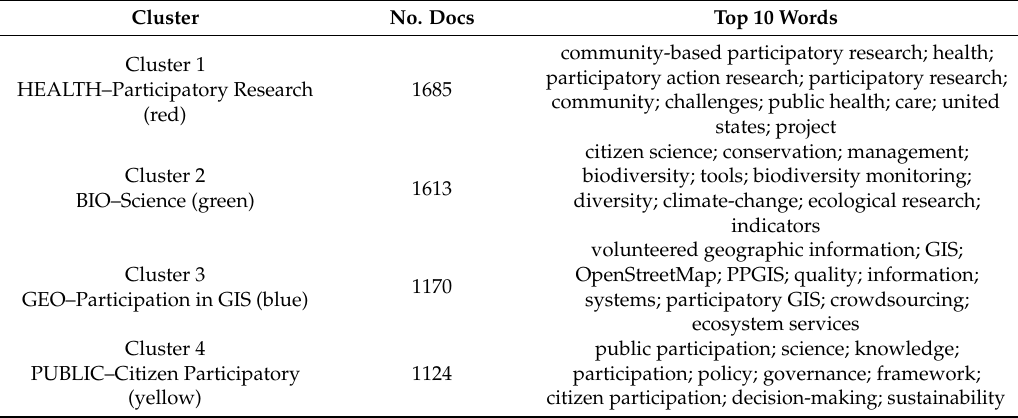
Table 3. Classification of publications by